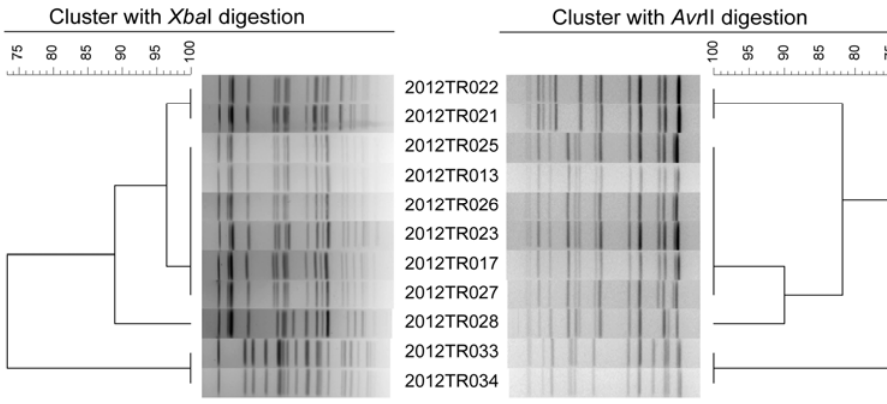
Figure 4. Clustering results of patterns obtained with Xba I- and Avr II-PFGE of 11 K. pneumoniae strains from one outbreak.